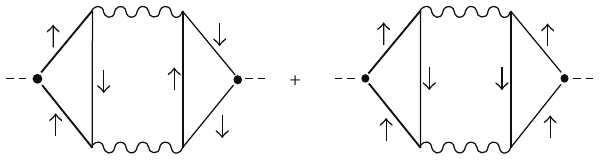
Figure 5: Vertex corrections from spin-up AL 1